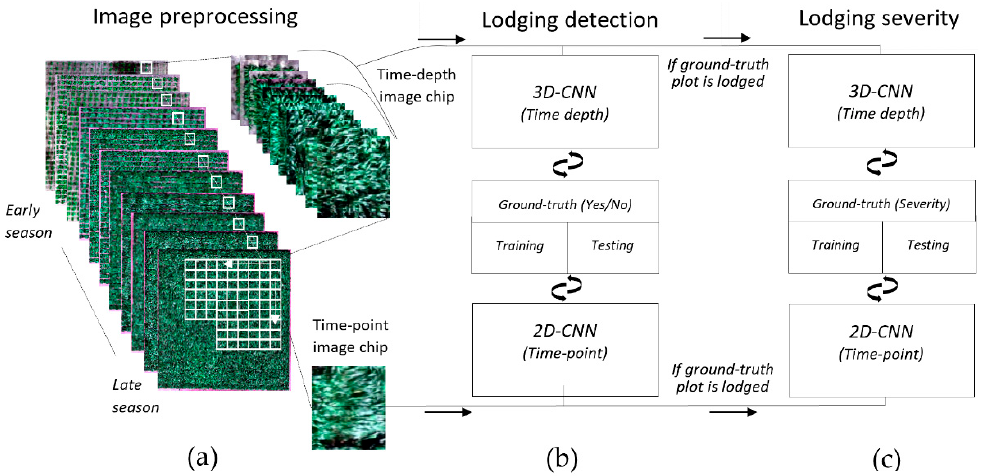
Figure 2. Schematic workflow for lodging assessment. Orthophotos stacking, extraction of time-depth image chips (top) and time-point image chips (bottom) ( a ). Implementation of lodging detection (classification) prediction based on time-depth 3D-CNN and time-point 2D-CNN modelling and ground-truth data as plots labeled as lodged or non-lodged ( b ). Implementation of lodging scoring (regression) using time-depth 3D-CNN and time-point 2D-CNN modelling approaches and ground-truth data as lodging severity scoring ( c ).